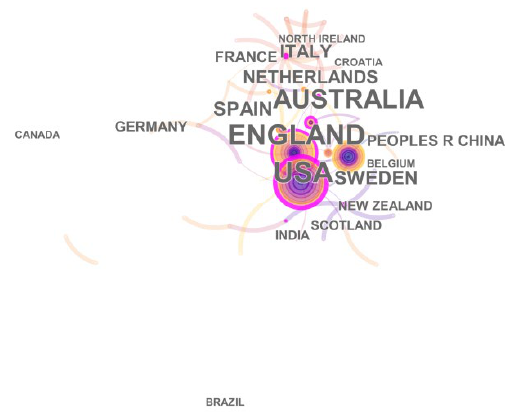
Figure 5. A visualization of the country collaboration